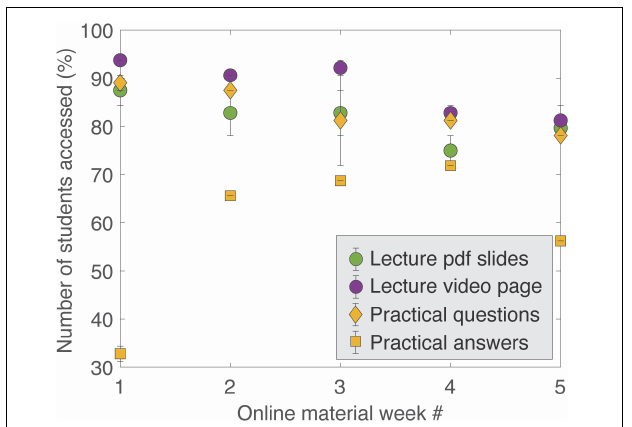
FIGURE 2 | The proportion of students accessing the material provided on the virtual learning environment. The online material has been split per week, as detailed in the course syllabus ( Table 1 ). Green circles represent the lecture slides in pdf format, purple circles represent the pages hosting the lecture videos, yellow diamonds represent the practical questions, and the yellow squares represent the answers to the practical exercises. Data points show the mean values, the error bars indicate the minimum and maximum values